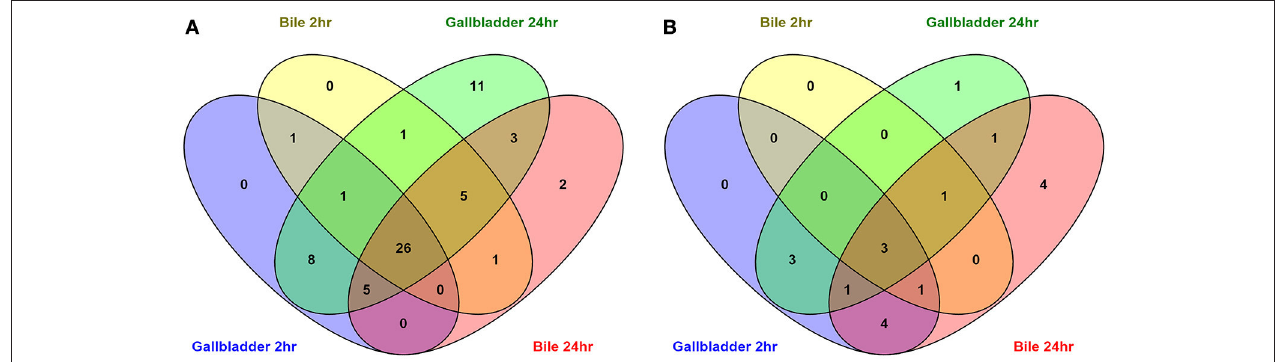
FIGURE 5 | Venn diagrams depicting the overlap of upregulated (A) and downregulated (B) predicted non-coding RNA unannotated genes in all conditions compared to the unexposed IA3902 inoculum. All putative ncRNA predicted by Rockhopper as differentially expressed under each condition were compared to each other utilizing the Venny